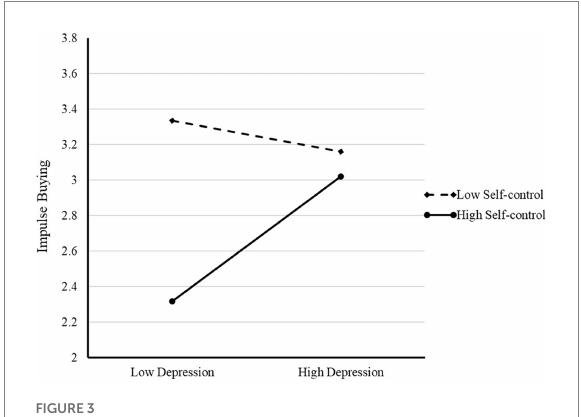
FIGURE 3 Self-control moderates the relationship between depression and impulse buying